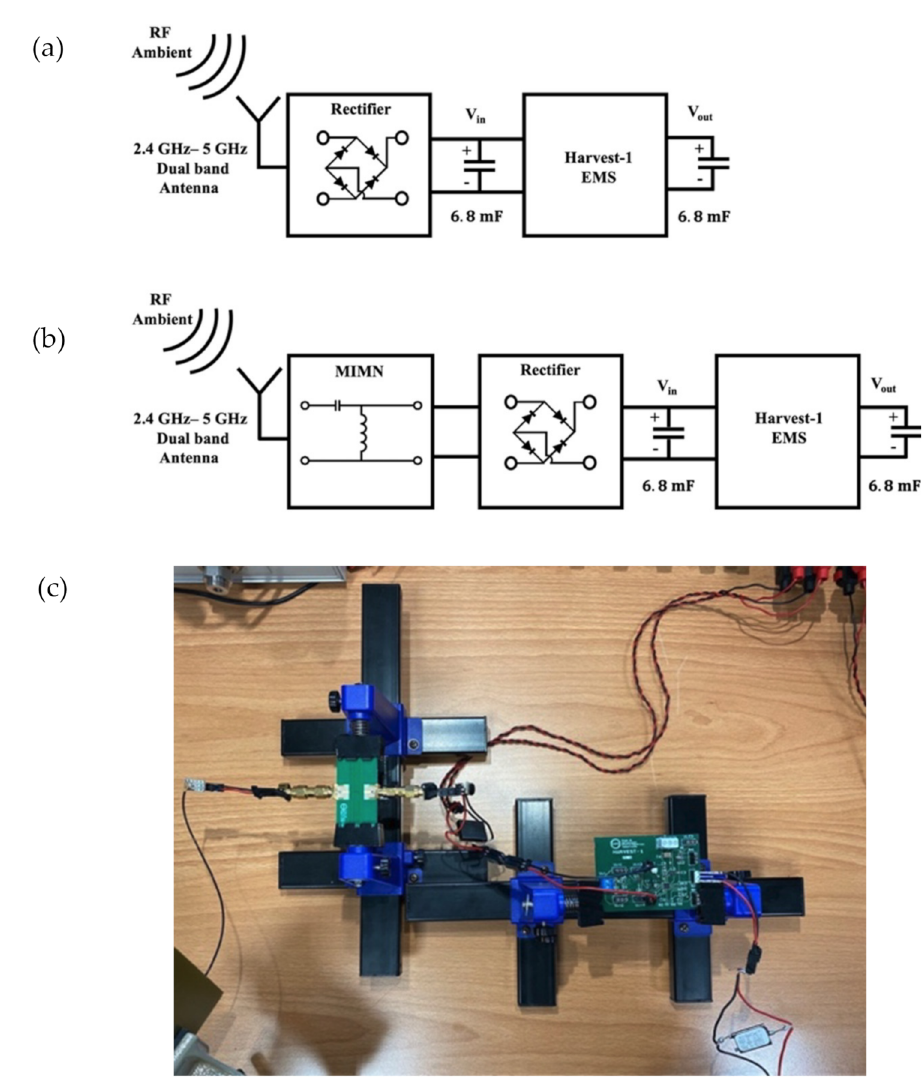
Figure 7. ( a ) Scheme of the RF-EH with not matching network (NM). ( b ) Scheme of the RF-EH system with matching network (MIMN). ( c ) Images of the experimental